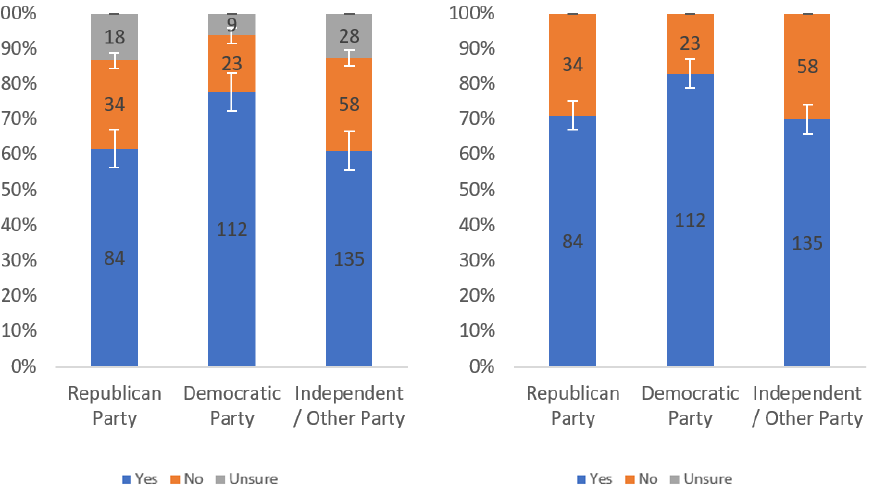
Figure 24. Responses regarding label helpfulness by party affiliation including ( left ) and excluding ( right ) unsure responses.